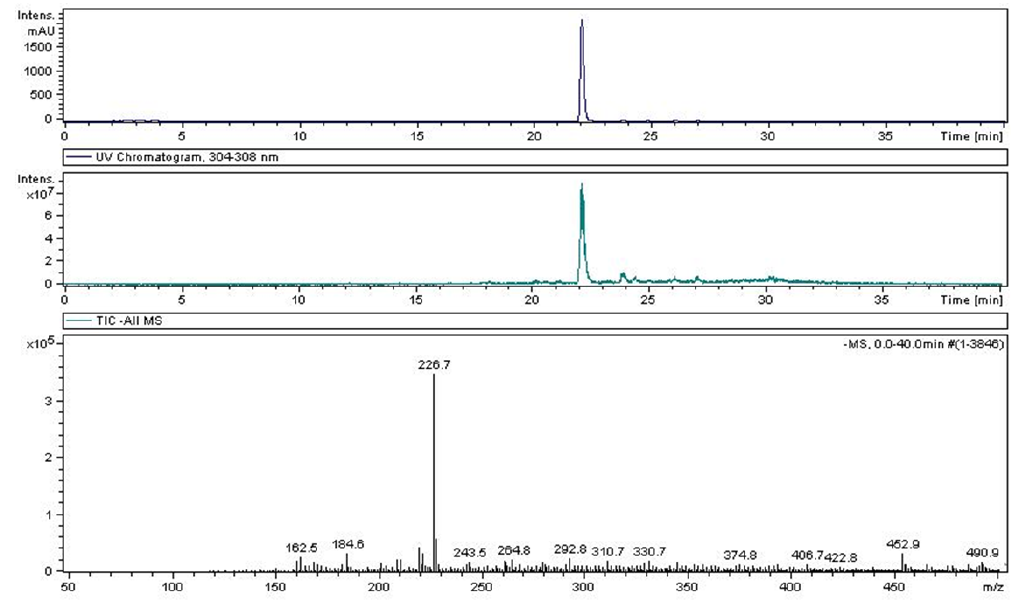
Figure 5. HPLC-UV chromatogram (at 306 nm) and HPLC-MS total ion chromatogram and averaged mass spectrum of the purified sample.